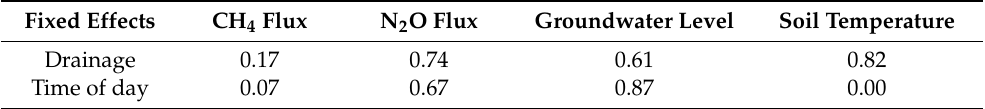
Table 3. p -values obtained from analysis of variance (ANOVA) of effects of drainage treatment and time of day (during 30 June 2018) on methane (CH 4 ) flux, nitrous oxide (N 2 O) flux, groundwater level (GWL) and soil temperature.